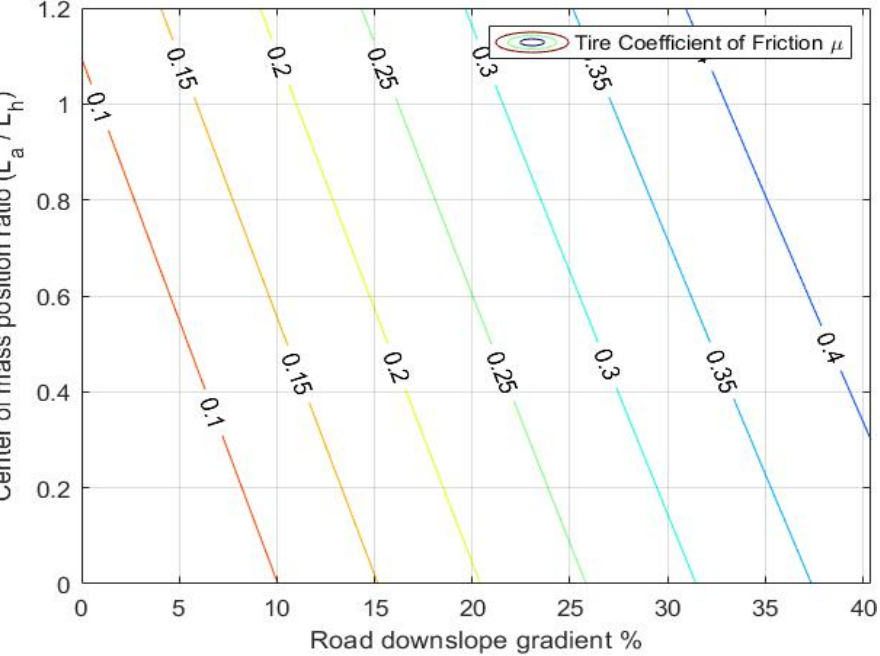
Figure 12. Minimum tire coefficient of friction before front wheel lock occurs for the bike and rider center of mass position ratio and road downslope gradient. Tire coefficient of friction is shown by the colored lines, with values increasing with the color gradient from red to blue.